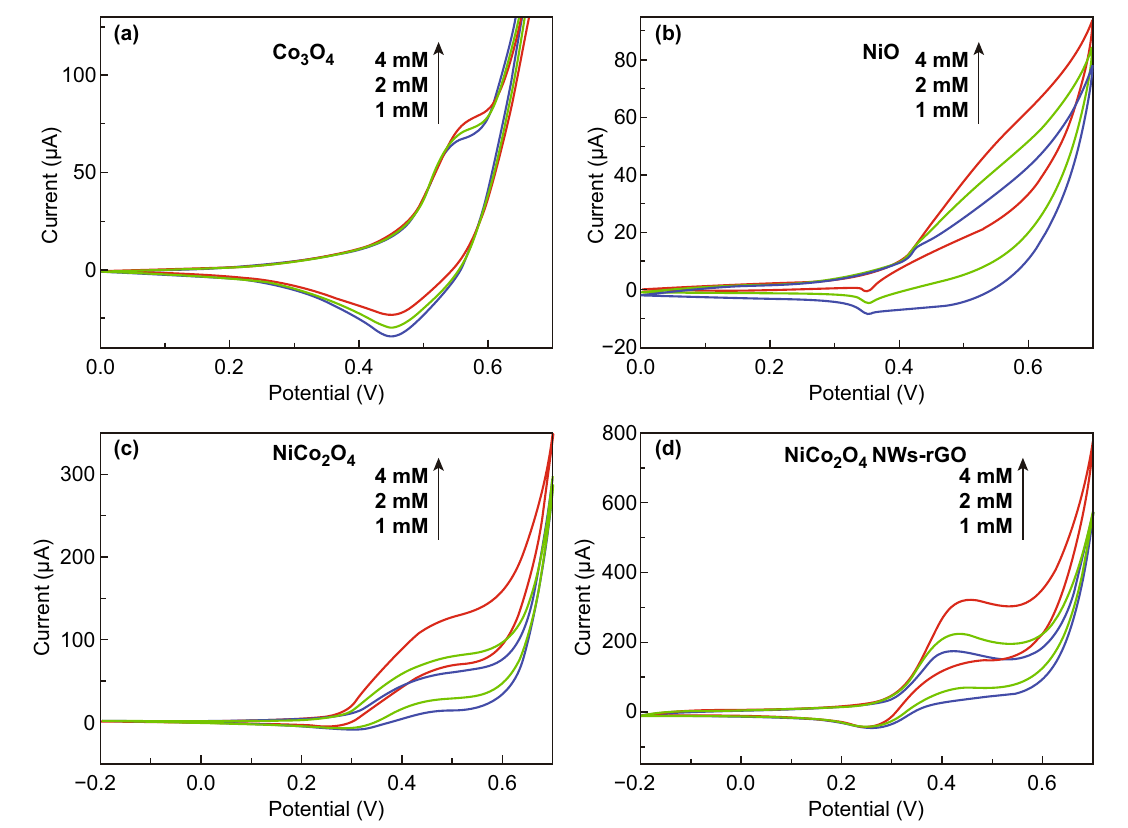
Fig. 27 CV plots for different glucose concentrations (1–4 mM) in 0.1 M NaOH a Co 3 O 4 , b NiO, c NiCo 2 O 4 , and d NiCo 2 O 4 nanowrinkles/ reduced graphene oxide-modified GCE. Reproduced with permission from Ref. [246]. Copyright © 2016 Elsevier